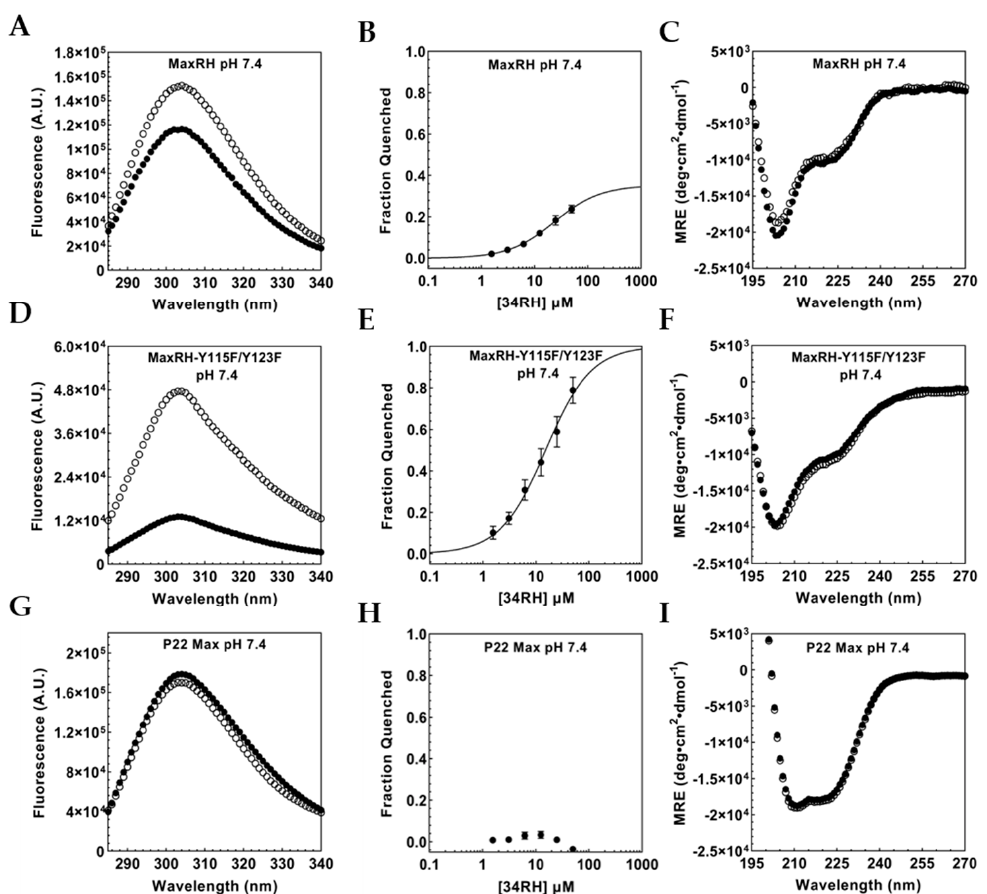
Figure 4. ( A ) Inner filter corrected fluorescence emission spectrum of 1 µ M MaxRH with (black circles) and without (white circles) 50 µ M 34RH. ( B ) Fraction quenched titration curve for 1 µ M MaxRH with 34RH fit to a Langmuir binding isotherm, K D = 23.4 ± 1.1 µ M ( C ) CD spectrum of 1 µ M MaxRH with (black circles) with without (white circles) 50 µ M 34RH. ( D ) Inner filter corrected fluorescence emission spectrum of 1 µ M MaxRH-Y115F/Y123F with (black circles) and without (white circles) 50 µ M 34RH. ( E ) Fraction quenched titration curve for 1 µ M MaxRH-Y115F/Y123F with 34RH fit to a Langmuir binding isotherm, K D = 14.9 ± 1.9 µ M ( F ) CD spectrum of 1 µ M MaxRH-Y115F/Y123F with (black circles) with without (white circles) 50 µ M 34RH. ( G ) Inner filter corrected fluorescence emission spectrum of 1 µ M P22 Max with (black circles) and without (white circles) 50 µ M 34RH. ( H ) Fraction quenched titration curve for 1 µ M P22 Max with 34RH ( I ) CD spectrum of 1 µ M P22 Max with (black circles) with without (white circles) 50 µ M 34RH at pH 7.4.